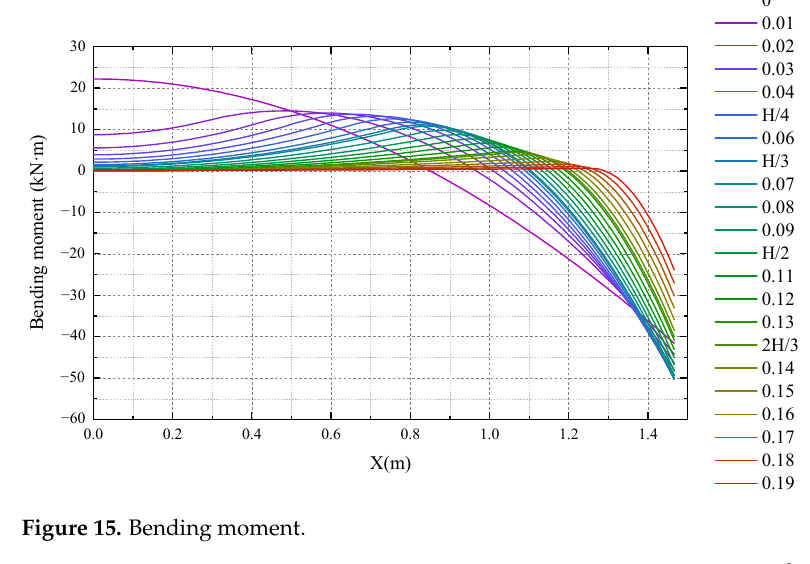
Figure 15. Bending moment.